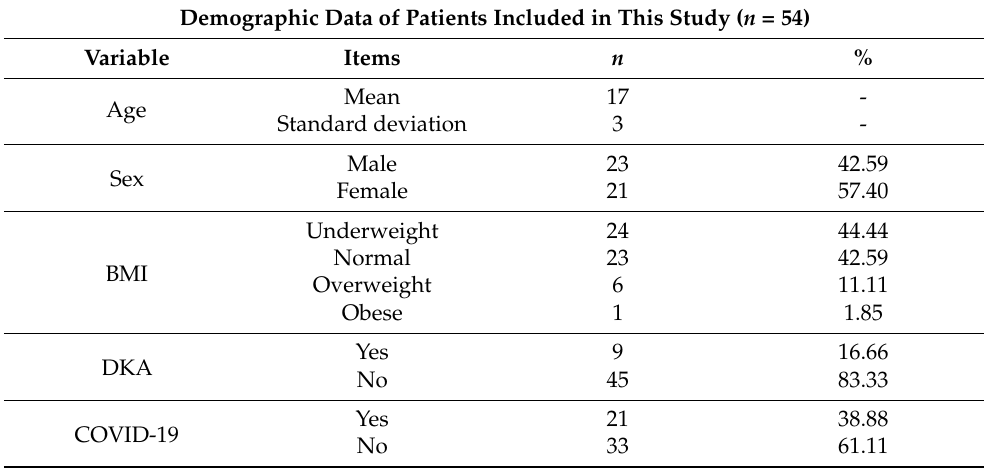
Table 1. Demographic data of patients included in this